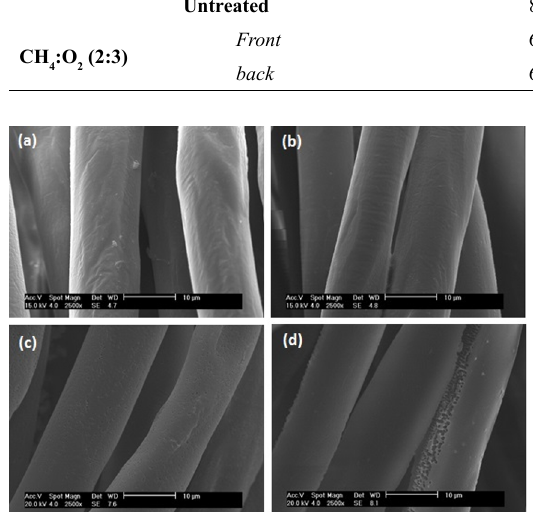
Figure 6. Image by scanning electron microscopy of the fabric: (a) front side of untreated sample, (b) back side of untreated sample, (c) front side after treatment with 100W, 30min and 40% CH , (d) back side after treatment with 100W, 30min and 40% 60% O 2 CH + 60% O 4 2